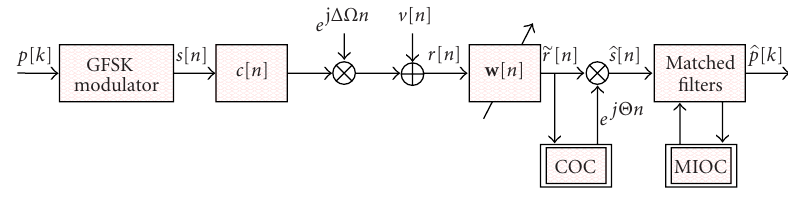
Figure 1: System